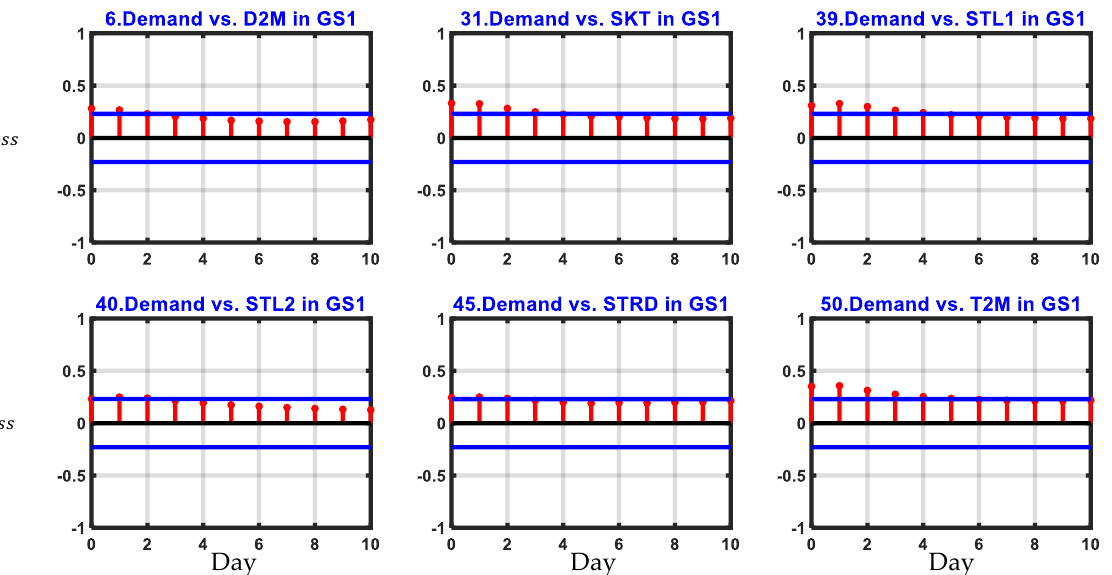
Figure 6. Six climate variables from ERA5 reanalysis were selected by using the cross-correlation function. The upper and lower bounds (blue lines) of the confidence interval were set between − 0.23 and 0.23. The chosen variables needed to have 3 (0:2) cross-correlation coefficients that were higher or lower than the bounds.